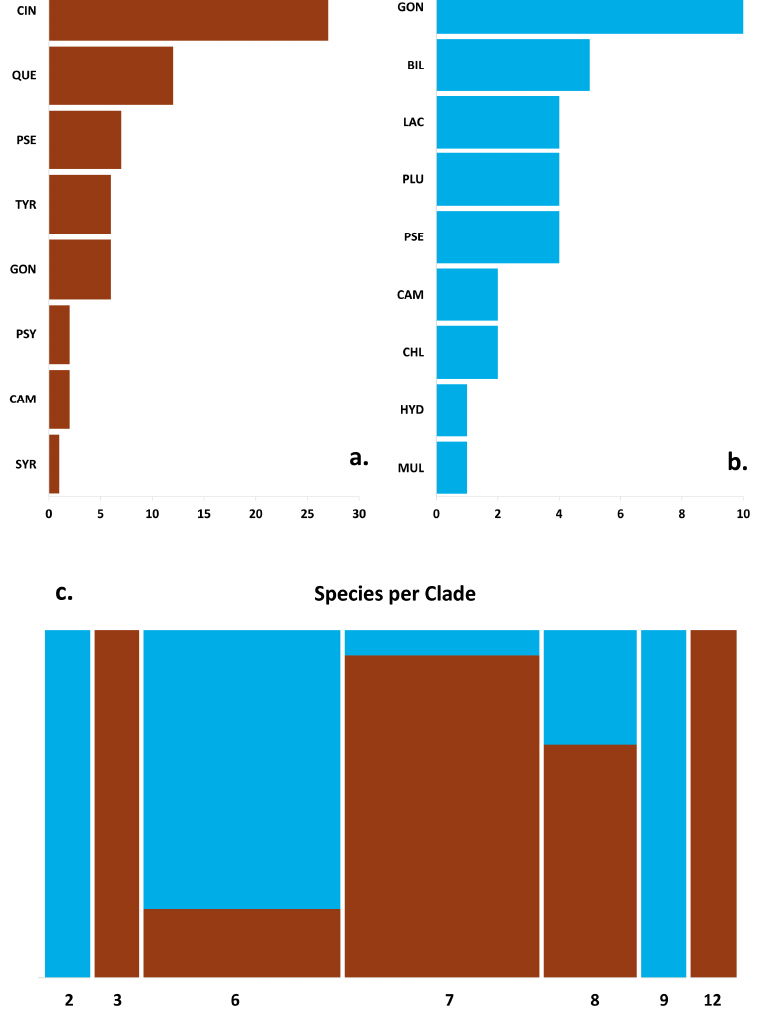
Figure 3. Diversity and frequency of the 8 soilborne ( a ) and 9 waterborne ( b ) Phytophthora species detected in this study; the horizontal axis is the count of sites. ( c ) Mosaic plot showing the distribution of soilborne (brown bars) and waterborne (blue bars) Phytophthora species grouped for phylogenetic clades. The bar width is proportional to the number of species, while bar heights show the relative proportion of soilborne and waterborne Phytophthora species per clade. CIN = P . cinnamomi , QUE = P . quercina , PSE = P . pseudocryptogea , TYR = P . tyrrhenica , GON = P . gonapodyides , PSY = P . psychrophila , CAM = P . × cambivora , SYR = P . syringae , BIL = P . bilorbang , LAC = P . lacustris , PLU = P . plurivora , CHL = P . chlamydospora , HYD = P . hydropathica , MUL = P . × multiformis .